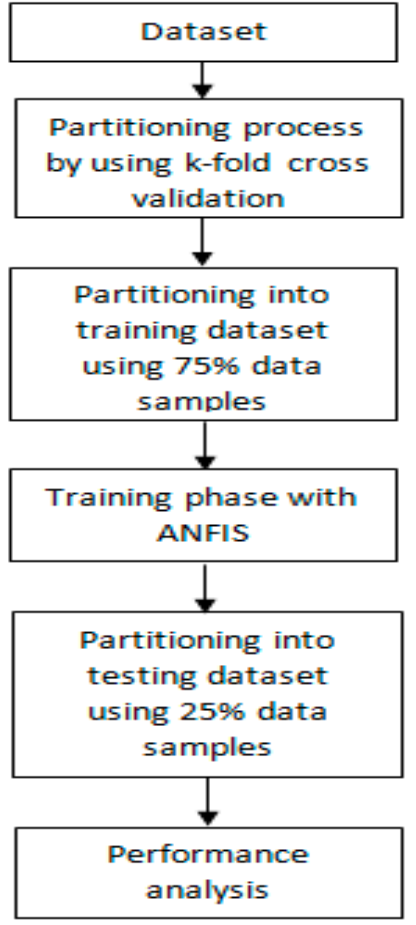
Figure 9. Flow diagram of developed intelligent system.